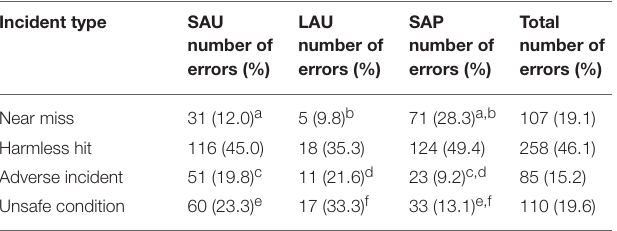
TABLE 8 | Distribution by occupation of reporters submitting incident reports at each hospital (see Figure 1 for hospital abbreviations). Occupation of reporters